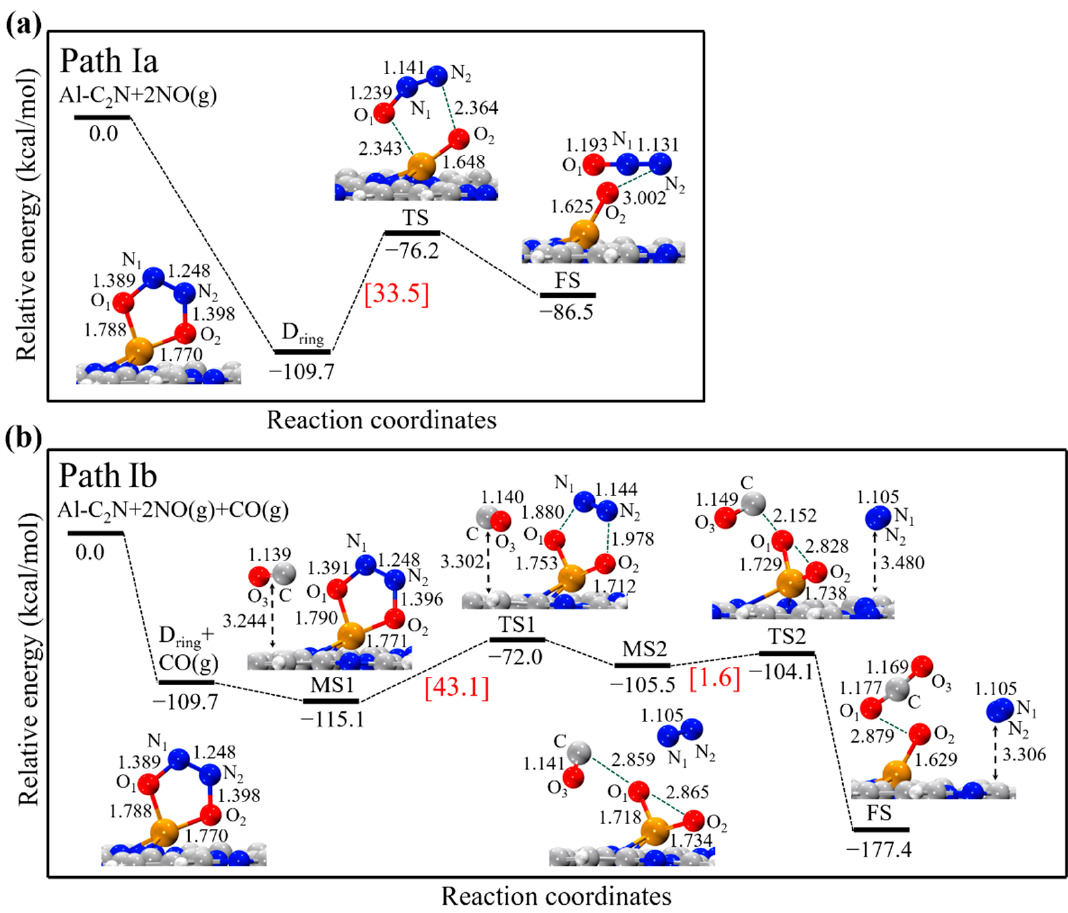
Figure 4. The energy profile and corresponding structure of the D ring dimer reduction process on Al-C 2 N; ( a ) (NO) 2 → N 2 O + O ads (path Ia), ( b ) (NO) 2 + CO → N 2 + CO 2 + O ads (path Ib). All bond lengths are in Å.